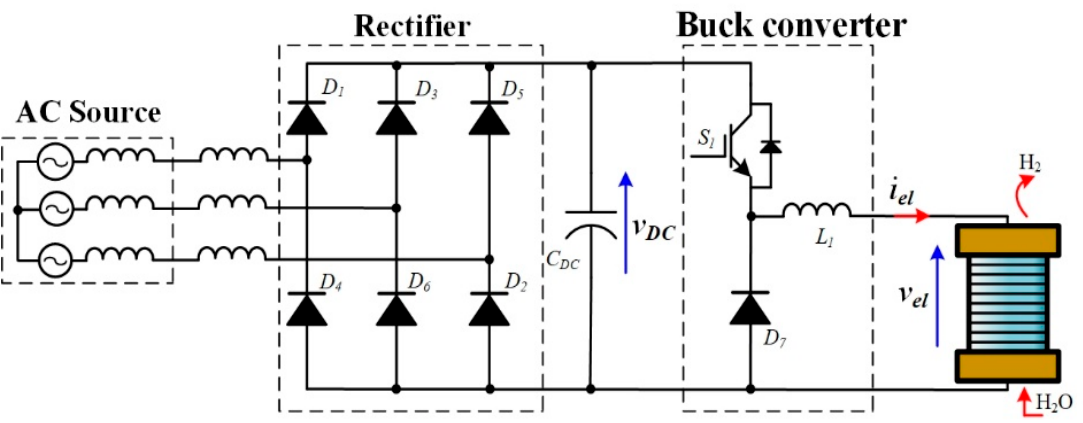
Figure 12. Six-pulse diode bridge rectifier with a buck converter.